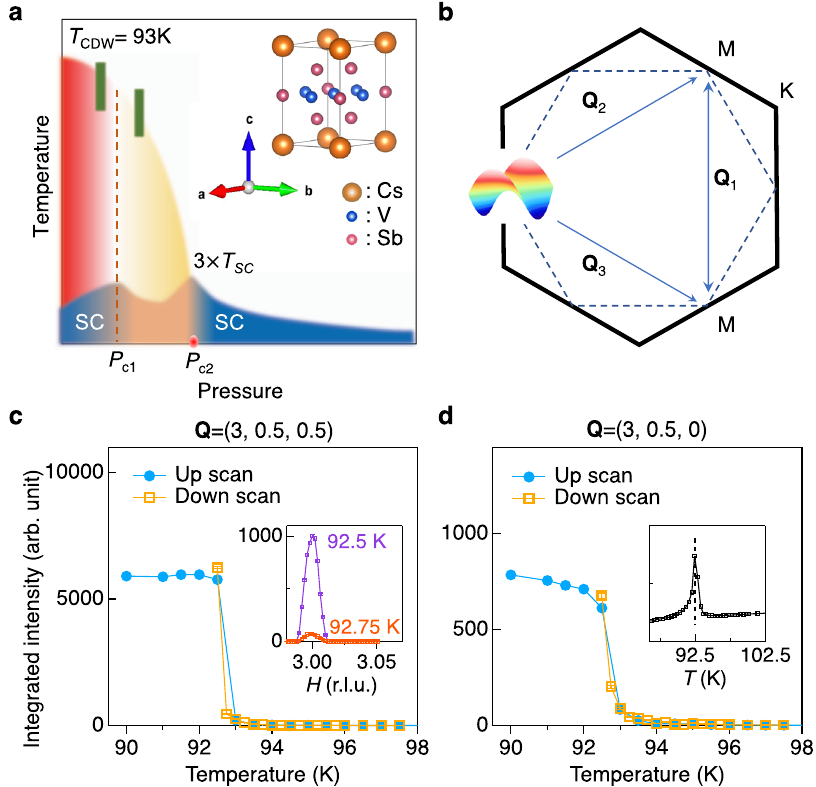
Fig.1|ChargedensitywaveinCsV 3 Sb 5 .a T-P phasediagramandcrystalstructure of CsV 3 Sb 5 (space group P6=mmm, no. 191). The phase diagram is separated by two characteristic pressures, P c1 and P c2 . The curvature of resistivity at T CDW changes sign at P c1 . At the same pressure, superconductivity reaches its fi rst peak. The green markers indicate pressures where the high-pressure X-ray diffraction measurementwasperformed(Fig.3). b AschematicofvanHovesingularitiesatthe M point of the hexagonal Brillouin zone. Theoretically, the van Hove fi lling induce Fermi surface instabilities with three nesting wavevector Q 1,2,3 . Integrated CDW intensityvstemperaturemeasuredat Q CDW =(3,0.50.5)( c )and(3,0.5,0)( d